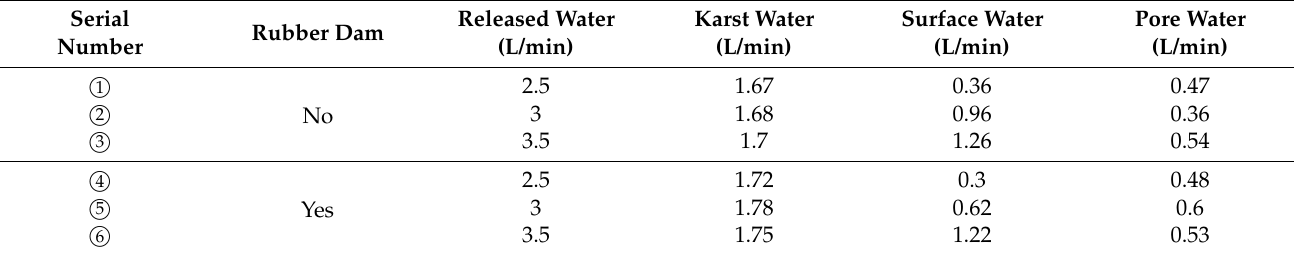
Table 3. Experimental results of the water